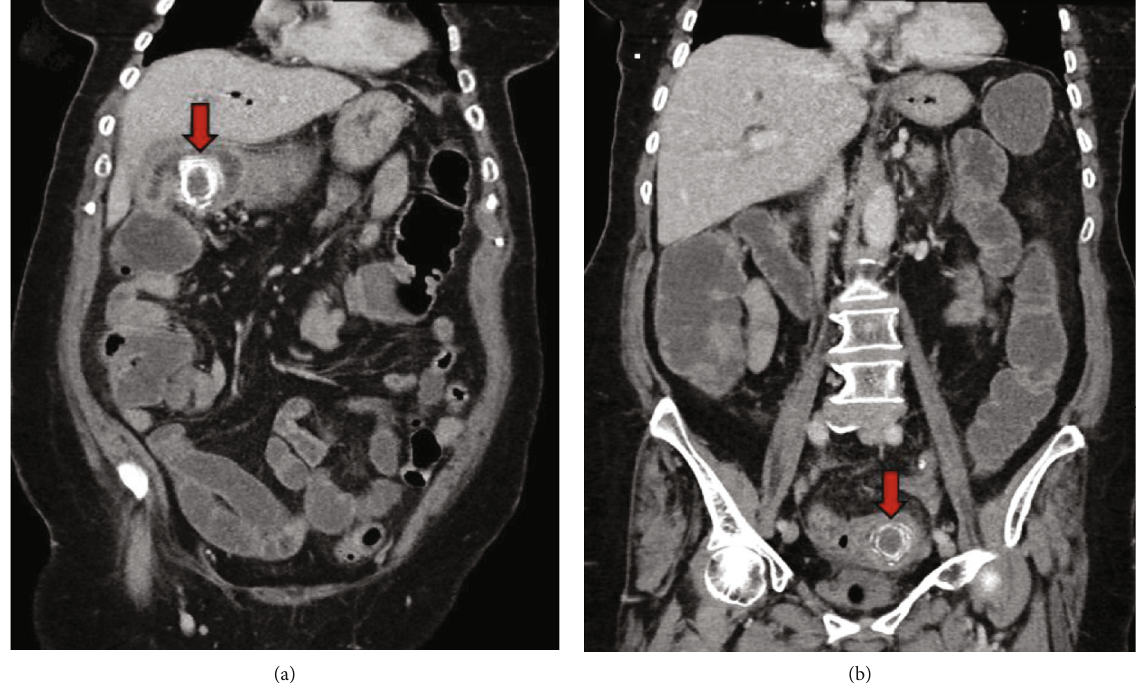
Figure 2: The fi rst gallstone in the fi rst part of the duodenum (a) and the second gallstone in the sigmoid colon (b) shown on coronal CT